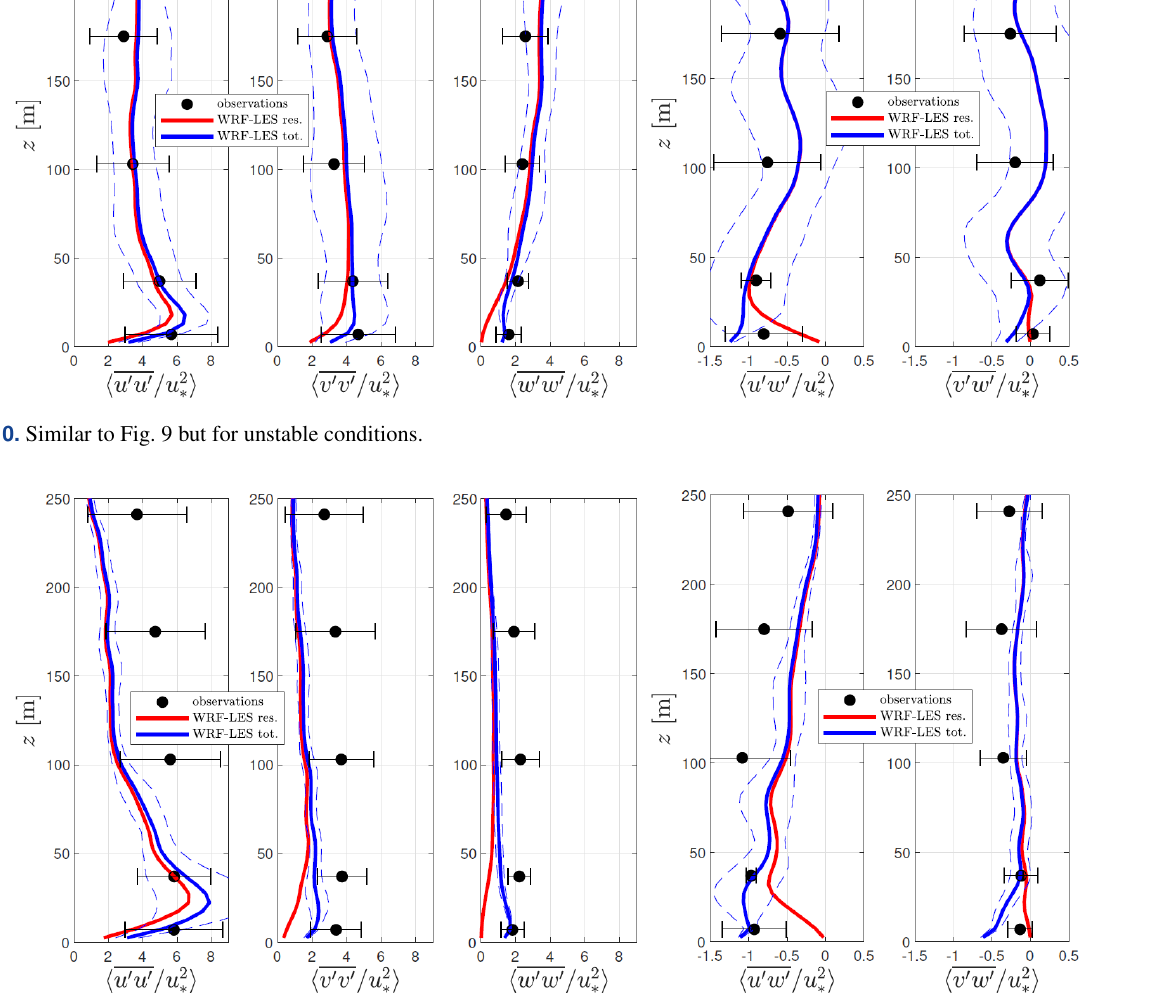
Figure 11. Similar to Fig. 9 but for stable